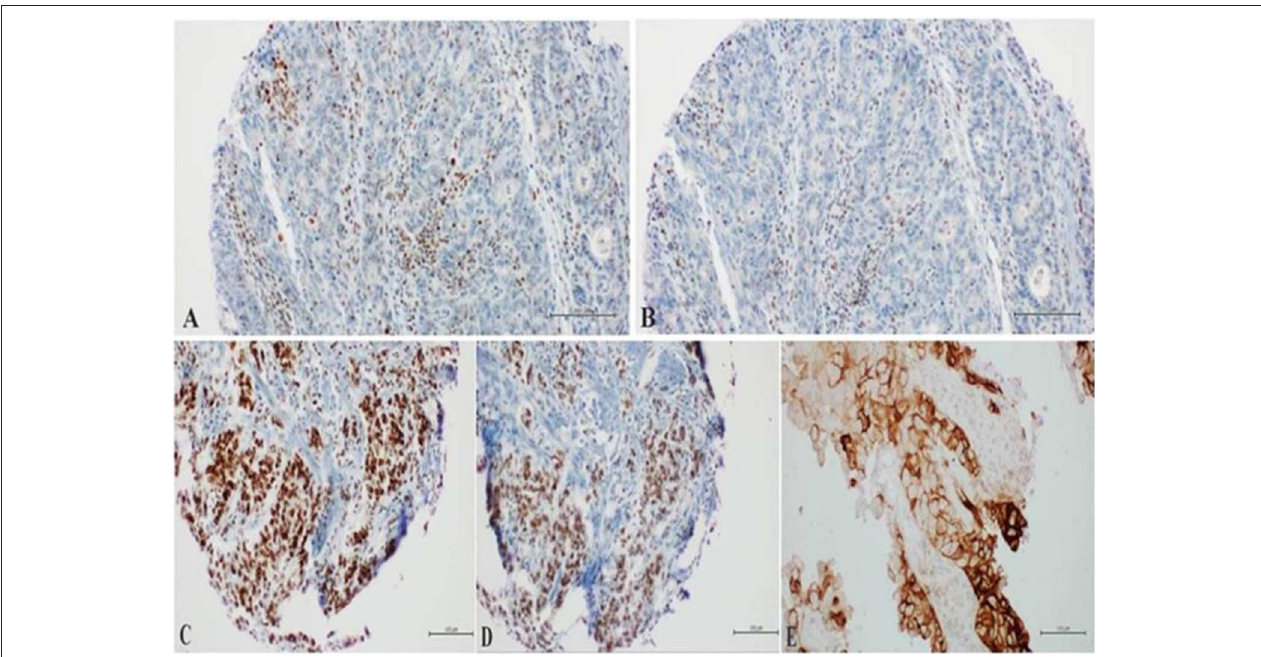
FIGURE 3 | (A,B) Loss of nuclear staining of MLH1/PMS2 heterodimer in neoplastic cells with nuclear positivity in the Tumor-Infiltrating Lymphocytes (Tils); (C,D) preserved nuclear staining of MSH2/MSH6 heterodimer in neoplastic cells; (E) expression of PD-Ll in the neoplastic cells with Moderate to Intense circumferential membrane staining